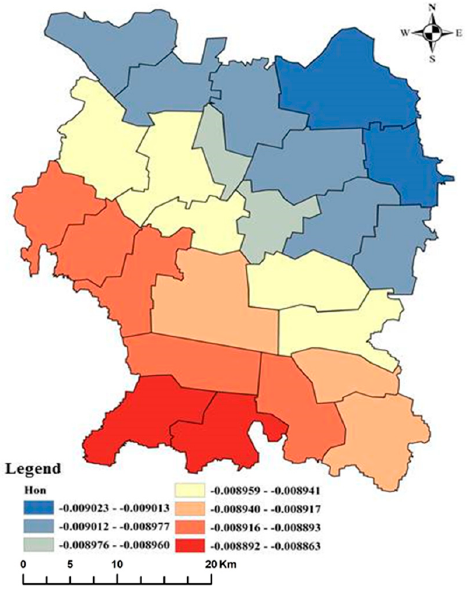
Figure 10. Regression coefficient of Hon.